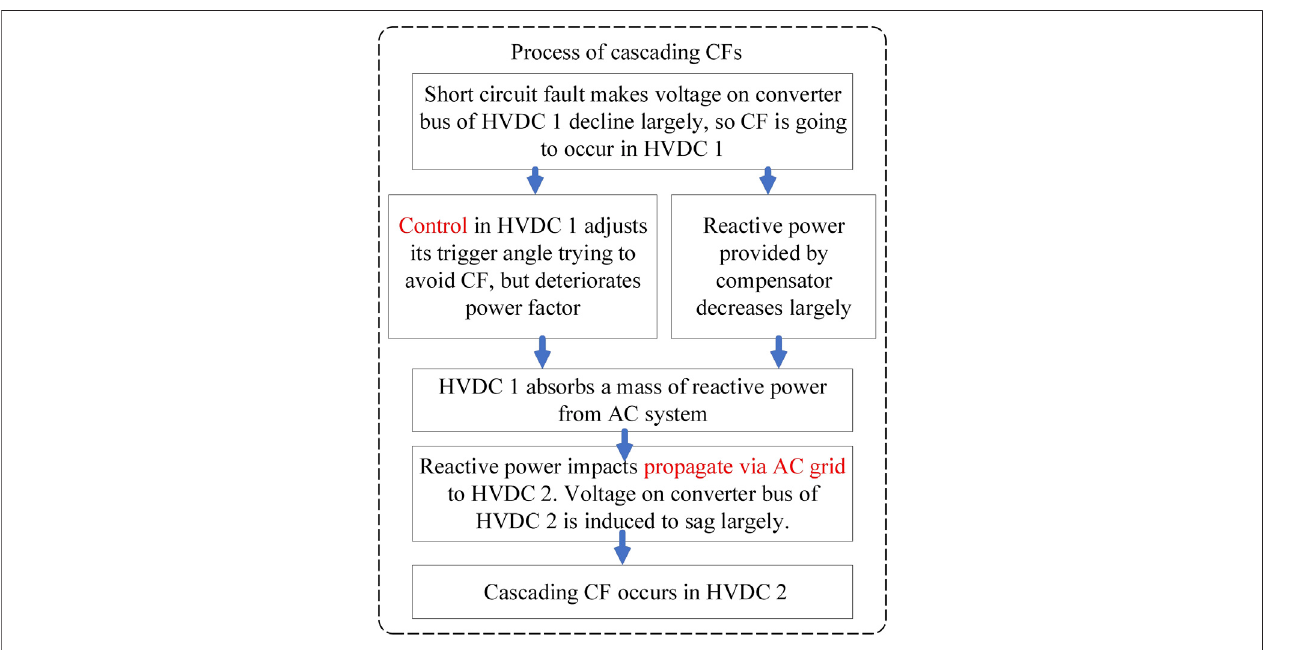
FIGURE 2 | Cascading process of CFs between two HVDCs in